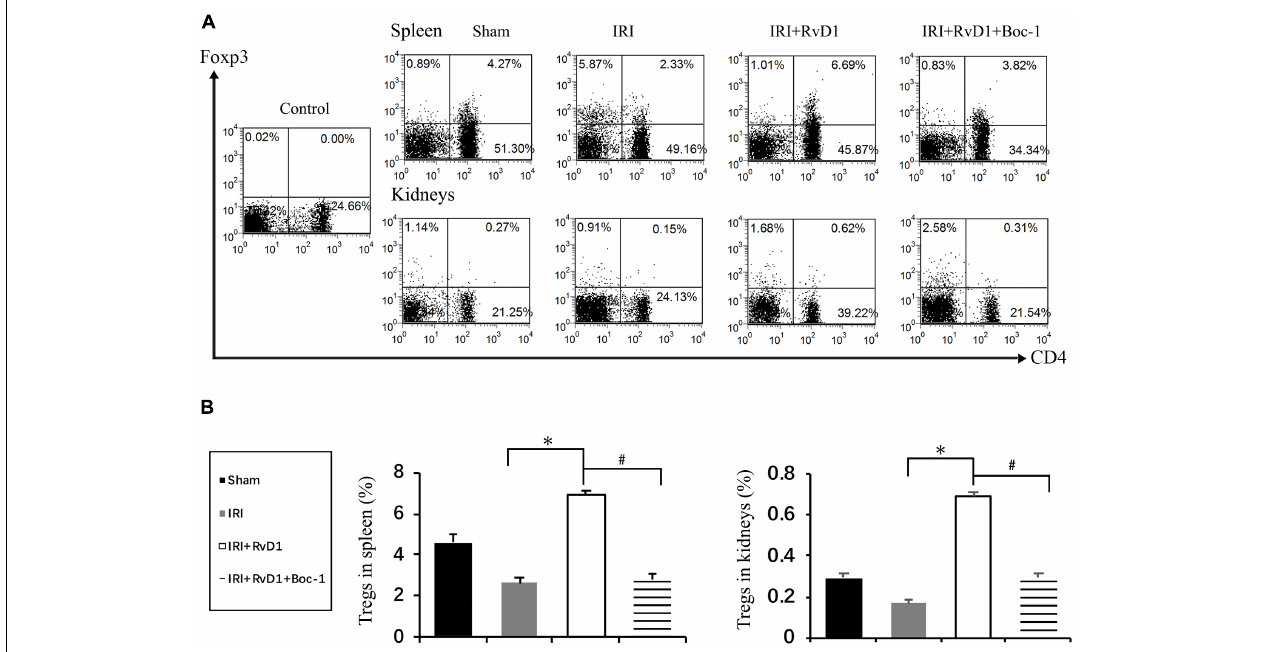
FIGURE 6 | Boc-1 abrogated the effect of RvD1 on the spleen and kidney cell Treg percentages. The IRI-AKI model was established and Boc-1 was administered via the tail vein after RvD1 or vehicle interventions. (A) Representative flow cytometry analysis of CD4 + Foxp3 + T cells obtained from the spleen or kidneys of IRI-AKI mice treated with or without RvD1 or Boc-1. The plots are gated for CD4 + lymphocytes. The data are representative of 3 independent experiments. (B) The percentage of CD4 + Foxp3 + T cells in the spleen or kidneys. Values are expressed as the means ± SDs, n = 6–8 per group. ∗ P < 0.05, IRI versus IRI + RvD1; # P < 0.05, IRI + RvD1 versus IRI + RvD1 +